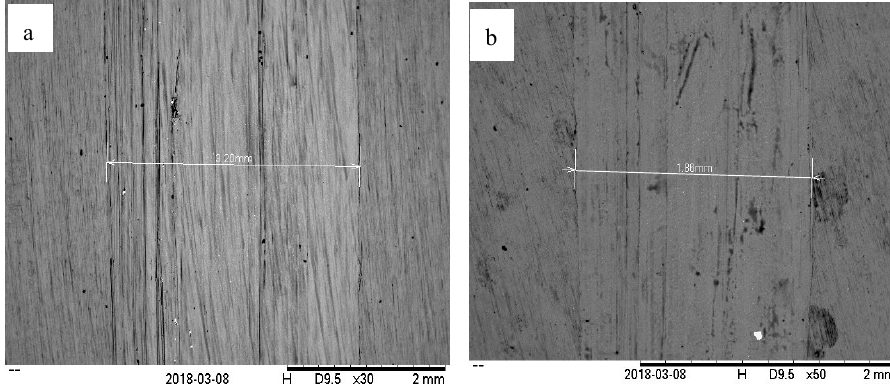
Figure 18. Wear quantity at ( a ) SAE 40 ( b ) 0.5.